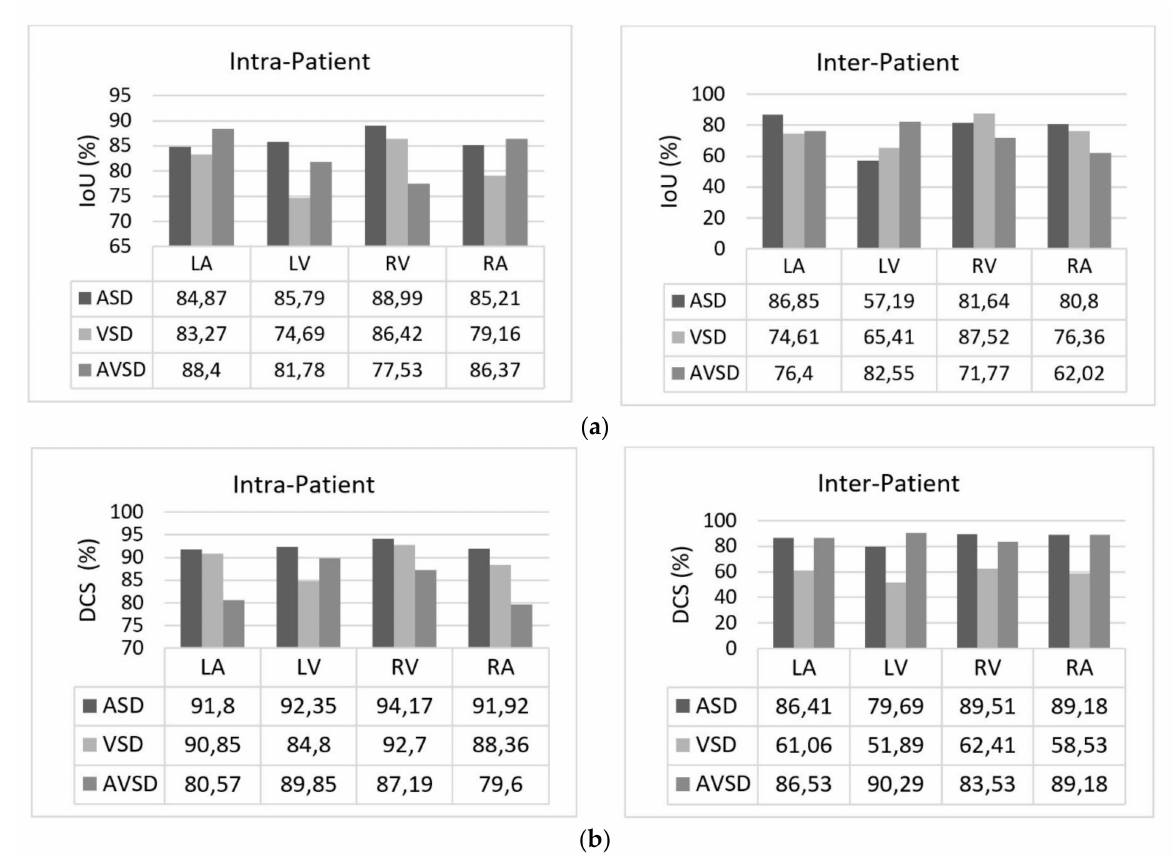
Figure 13. The performance in fetal heart chamber segmentation in 4CH view based on intra- and inter-patient scenario: ( a ) IoU and ( b ) DCS.